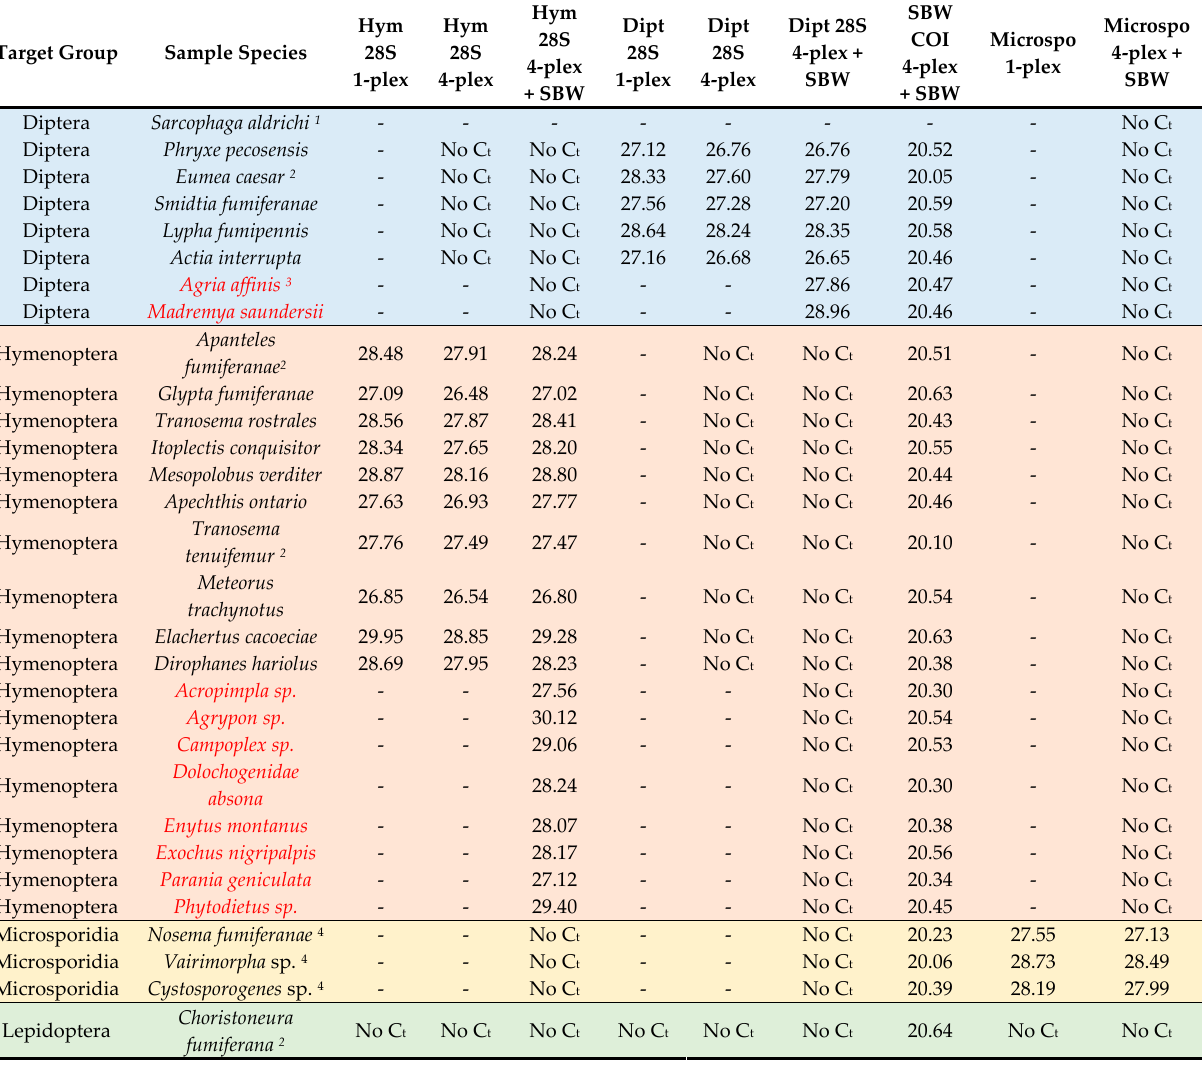
Table 4. Validation assays for Module 1 of the molecular sorting tool, using ca. 100 copies of the 28S rDNA gene (purified DNA or crude lysates), tested in 1-plex and 4-plex formats, as well as in 4-plex format spiked with spruce budworm (SBW) DNA (10